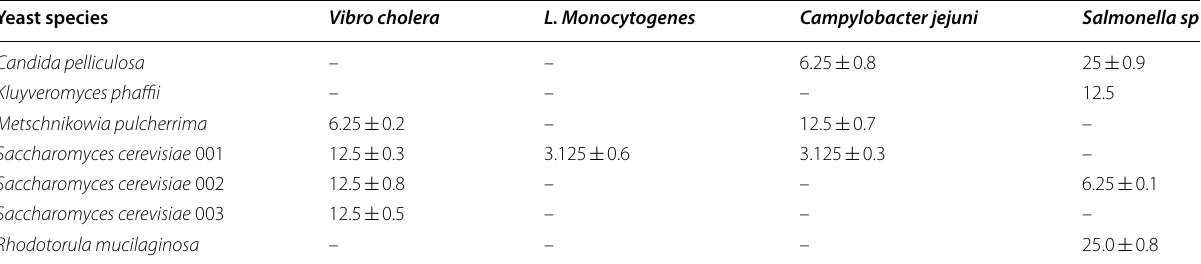
Table 9 Minimum inhibitory concentration (μg/ml) of yeast isolates against test